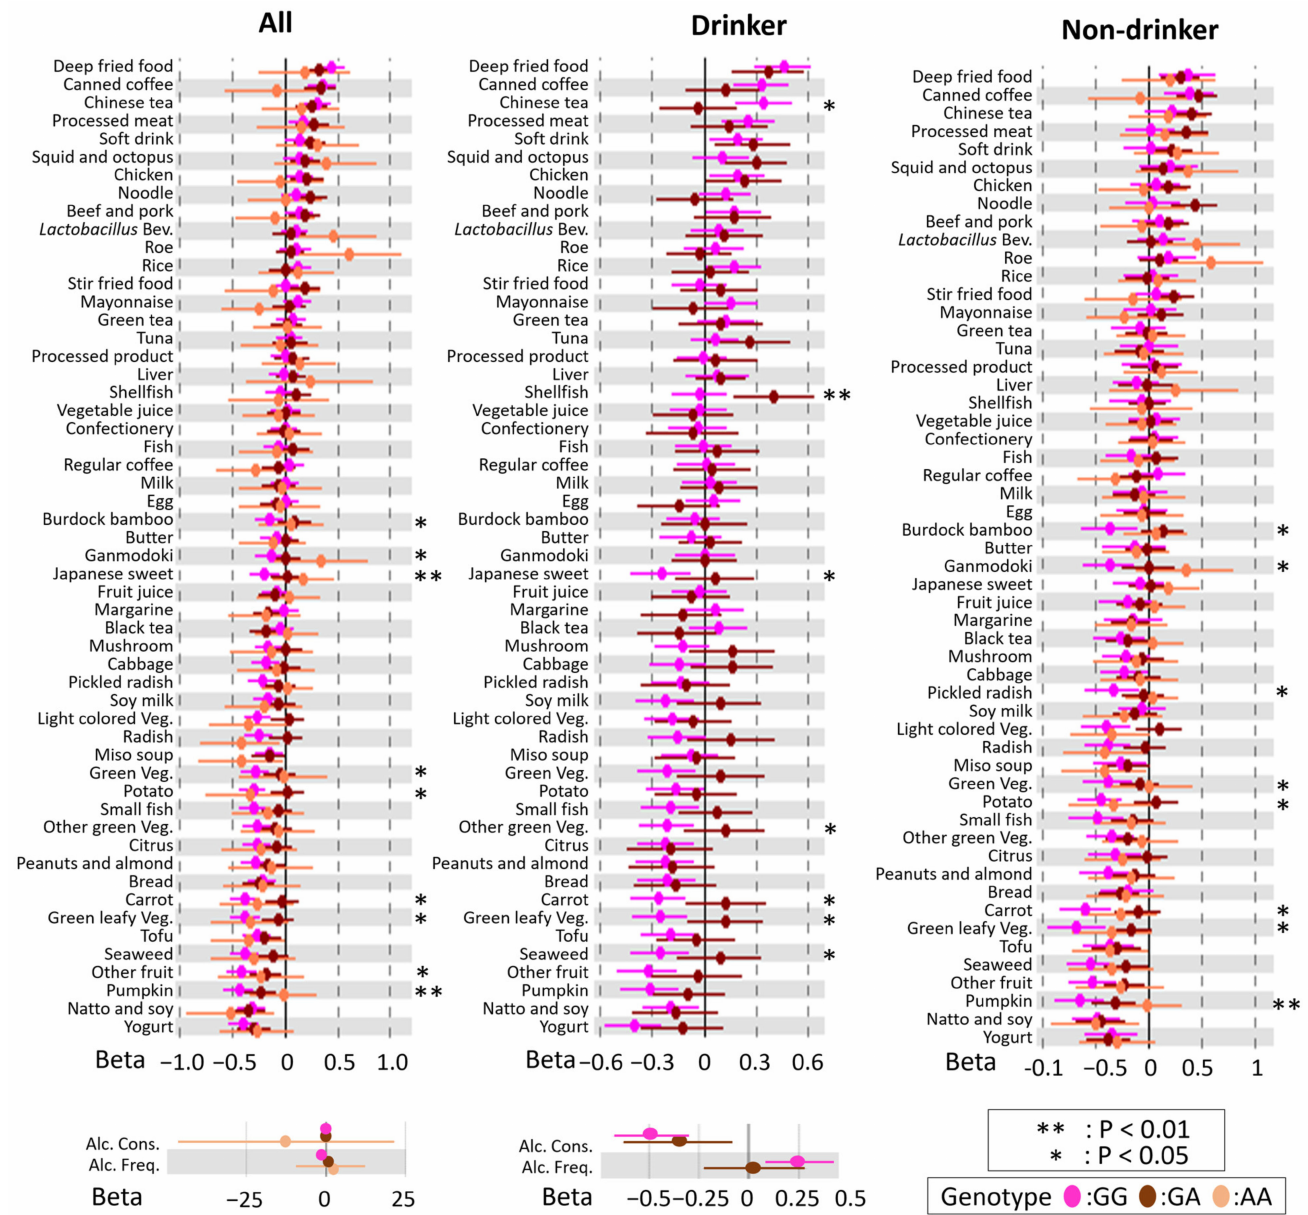
Figure 3. Forest plot showing association between dietary behaviors (DBs) and BMI modified by rs671 genotype in females. The X -axis and Y -axis show the standardized beta coefficient ± standard deviation and each DB, respectively. Pink, blown, and beige spots indicate the results for GG, GA, and AA types of rs671 genotypes, respectively. Alc. Cons, alcohol consumption; Alc. Freq., alcohol frequency; Lactobacillus Bev., Lactobacillus beverage; Green Veg, green vegetable; Green leafy Veg., green leafy vegetable; Green-yellow Veg, green-yellow vegetable; Light-colored Veg., light-colored vegetable. Asterisks indicate statistical significance for heterogeneity (**, p < 0.01; *, p <